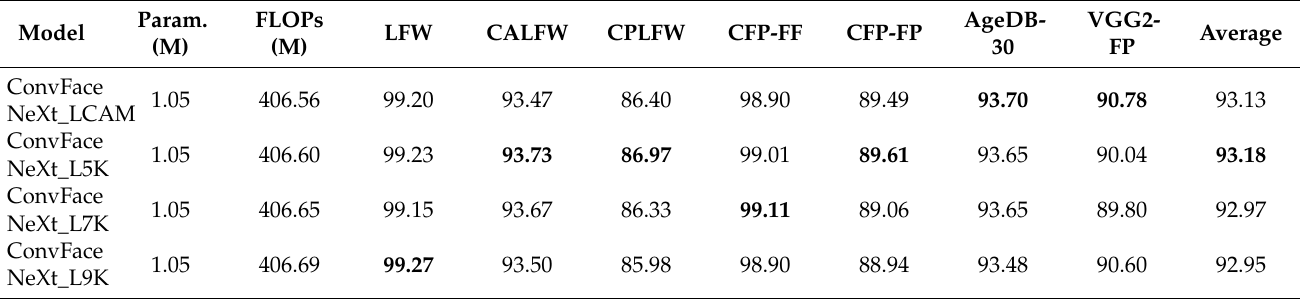
Table 1. Performance results of different kernel sizes. These results are reported in terms of parame- ters, FLOPs, and verification accuracy for LFW, CALFW, CPLFW, CFP-FF, CFP-FP, AgeDB-30, and VGG2-FP. Moreover, the average accuracy for the seven image-based datasets is shown in the last column. (Bold values are the highest obtained values by the methods).